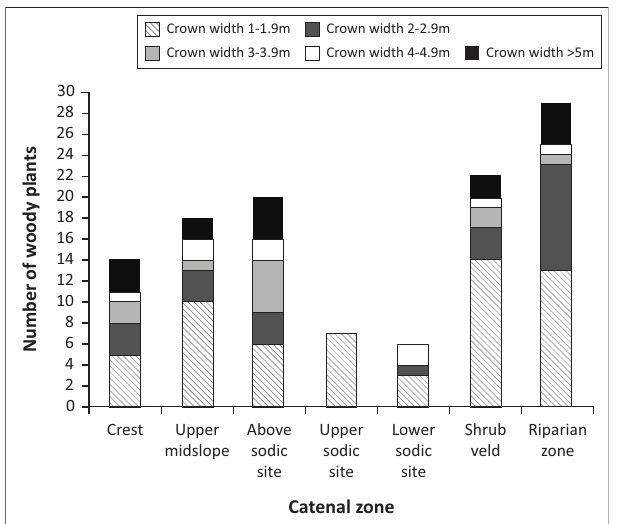
FIGURE 2: The numbers of woody plants with maximum crown width in a specific size range are indicated for each transect that represents a catenal